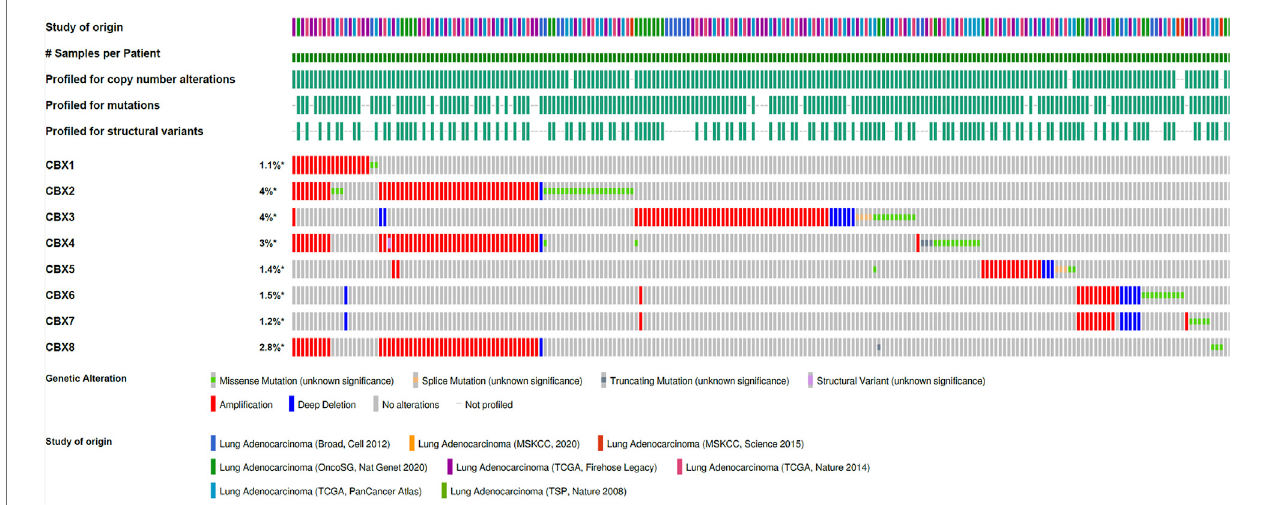
FIGURE 3 | Ampli fi cation and mutation of CBX family members in LUAD. Genomic variations of CBX family members in 3098 cases were analyzed using the cBioPortal database.